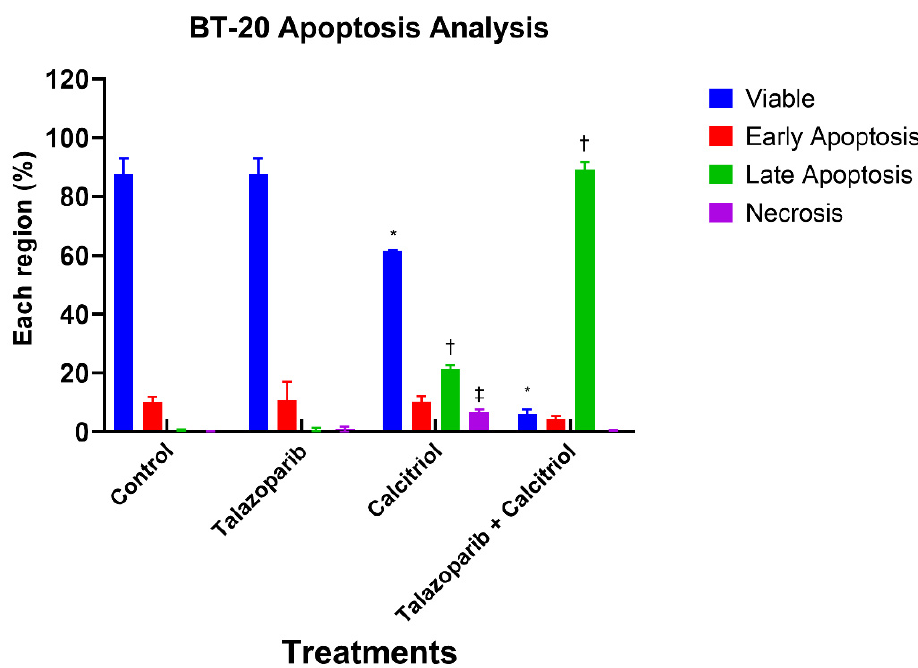
Figure 8. Histogram for apoptosis rate in BT − 20. Data are represented as means ± standard deviation (SD) of three independent experiments where (*) indicates a significant difference of viable cells between treatment groups versus the control group as * p < 0.05. (†) indicates a significant difference of late apoptosis between treatment groups versus the control group as † p < 0.05. (‡) indicates a significant difference of necrosis between treatments versus the control group as ‡ p < 0.05. Data were compared between the untreated control and the treatment groups by a one − way ANOVA post − hoc